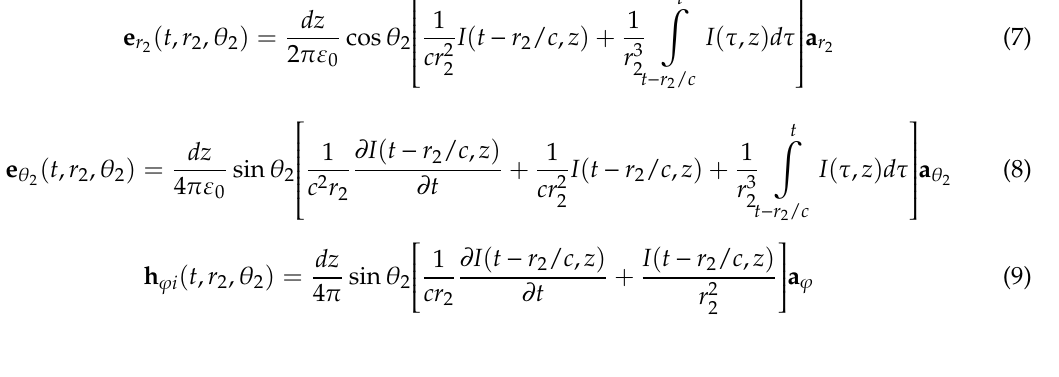
Figure 2. Geometry pertinent to the evaluation of electromagnetic fields from the lightning return stroke channel. The diagram also shows the vectors necessary for writing down the electromagnetic fields from a small channel element. The vector ϕ a is in the direction of r θ